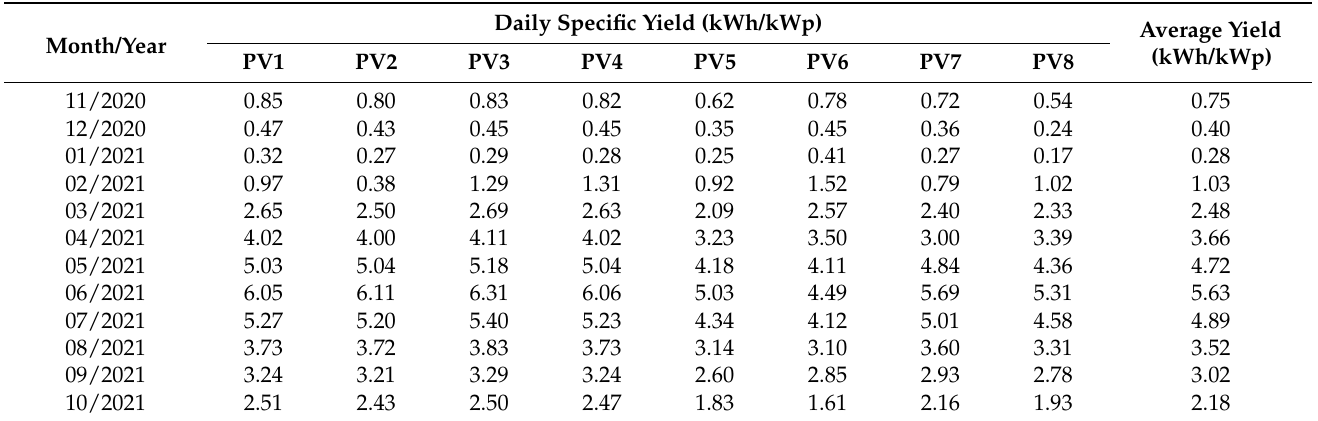
Table 4. Summary of daily specific yield obtained by the analyzed systems.